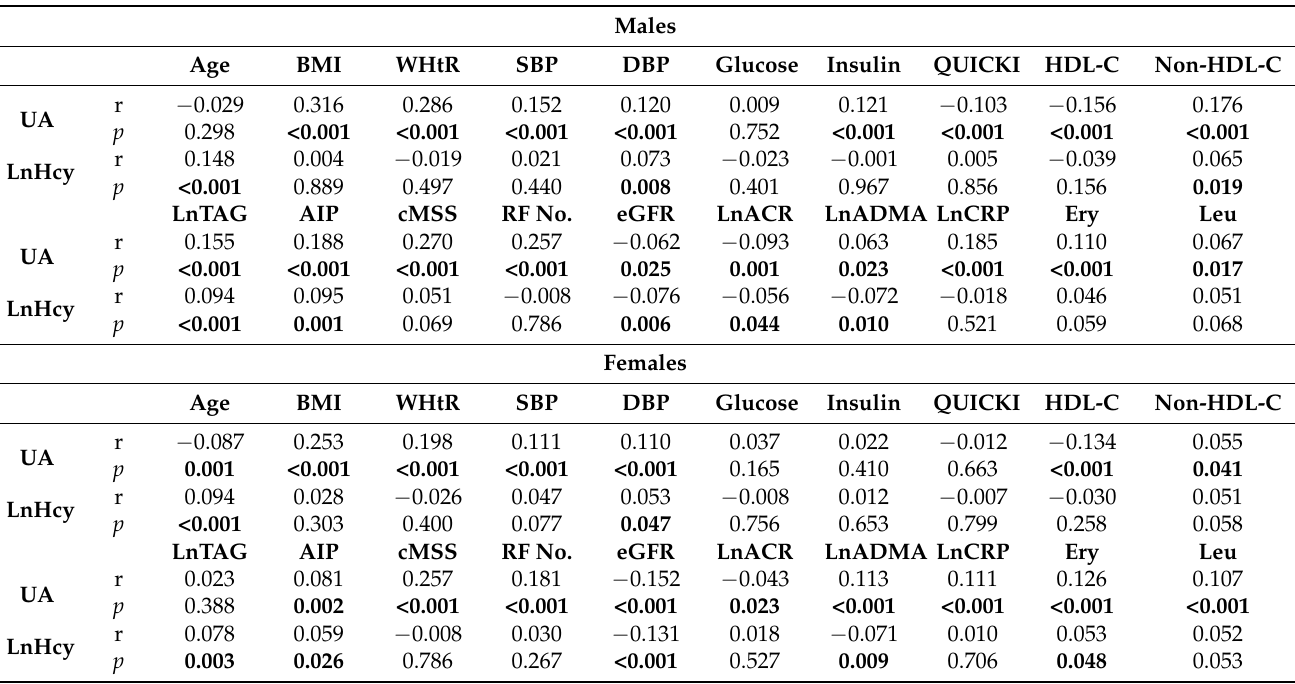
Table 2. Pearson correlations between selected cardiometabolic markers and uric acid or homocys- teine in males and